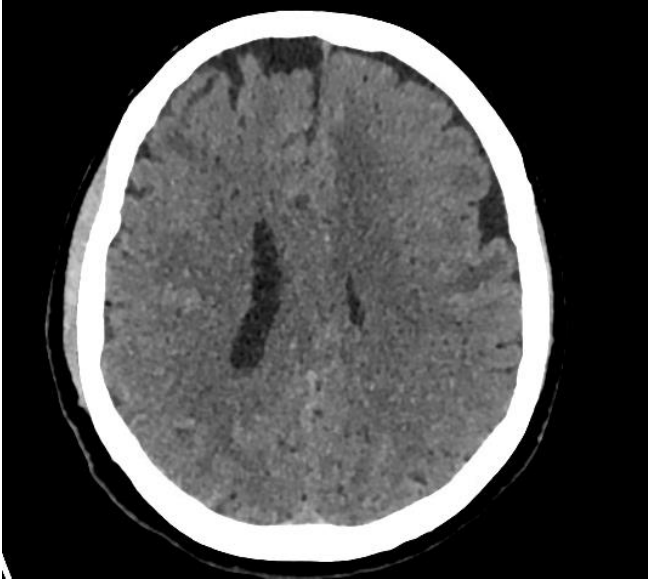
Figure 1. CT brain from patient’s initial presentation showing left frontal oedema with associated mild mass effect.